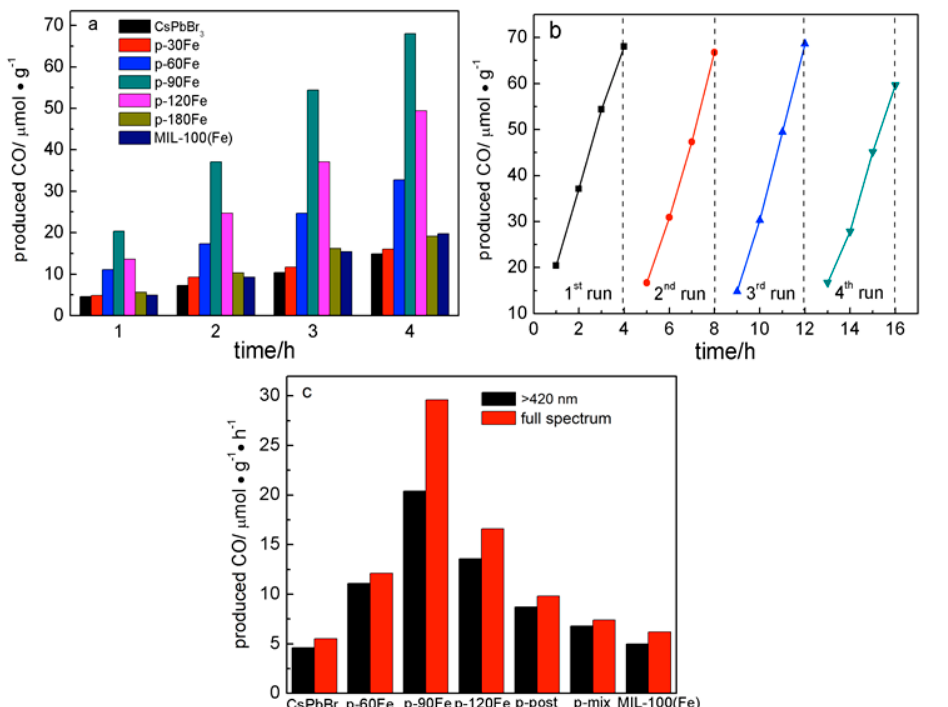
Figure 7. ( a ) Time-dependent CO generation over the synthesized MIL-100(Fe), CsPbBr 3 , and composites, ( b ) Stability test on p-90Fe for four consecutive runs (4 h each, in total 16 h), and ( c ) CO generation over the photocatalysts under different illumination conditions.